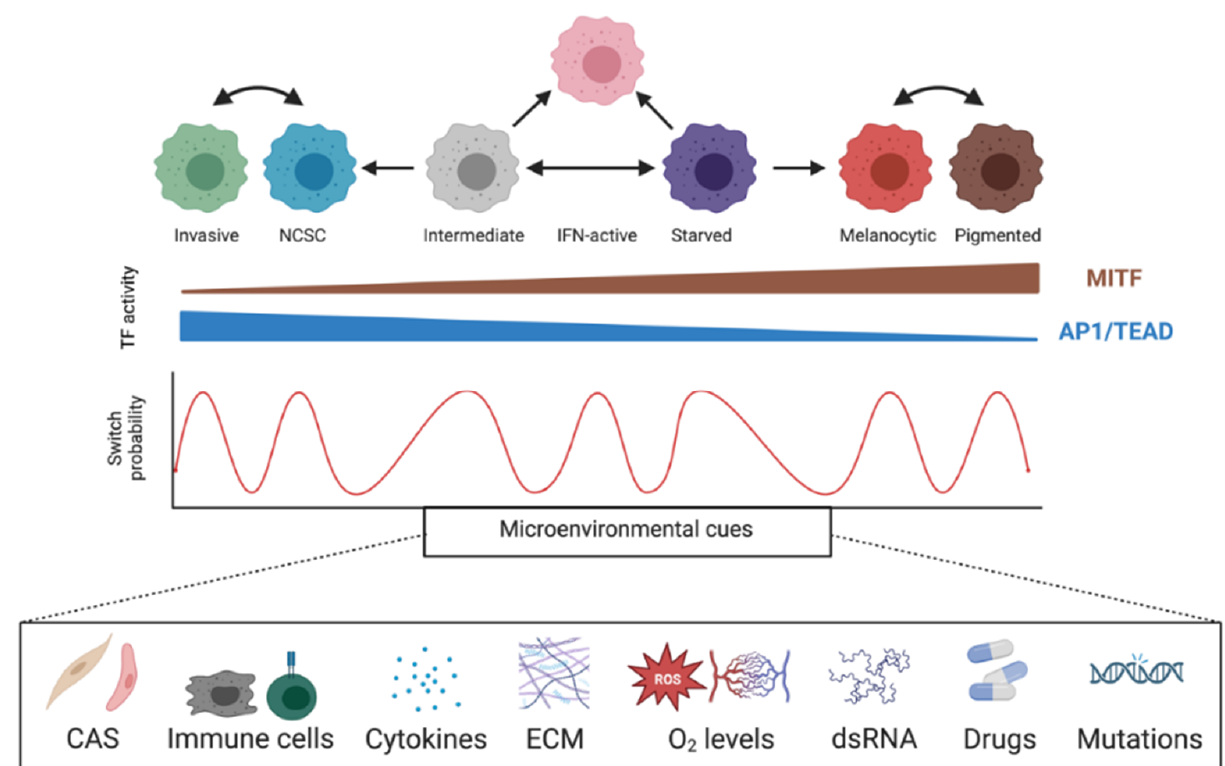
Figure 3. Tumor microenvironment drives phenotypic diversity in melanoma. The tumor microenvironment is characterized by the juxtaposition of heterotypic interactions between healthy tissue and melanoma cells, influencing two opposing MITF- or AP1/TEAD-dependent transcriptional programs that define distinct phenotypic states. Phenotype-switching represents a dynamic adaptation to microenvironmental variation comprising immune infiltration, inflammation, extracellular matrix (ECM), nutrient availability, oxygen levels, and melanoma-cell-autonomous mechanisms, such as de novo mutations and double-stranded RNA (dsRNA) regulation. CAS: cancer-associated stroma.